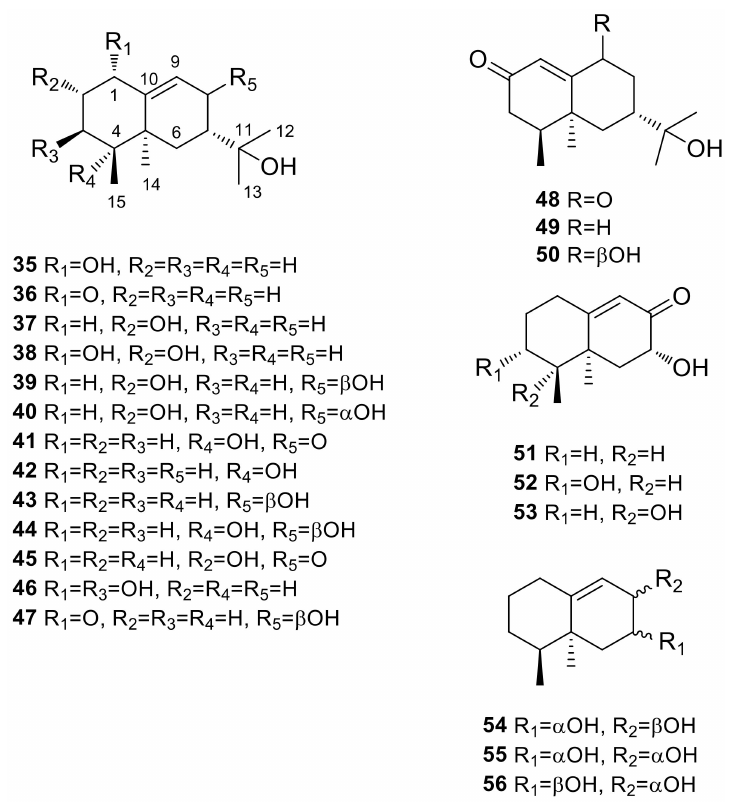
Figure 13. Eremophilene derivatives isolated from B. cinerea